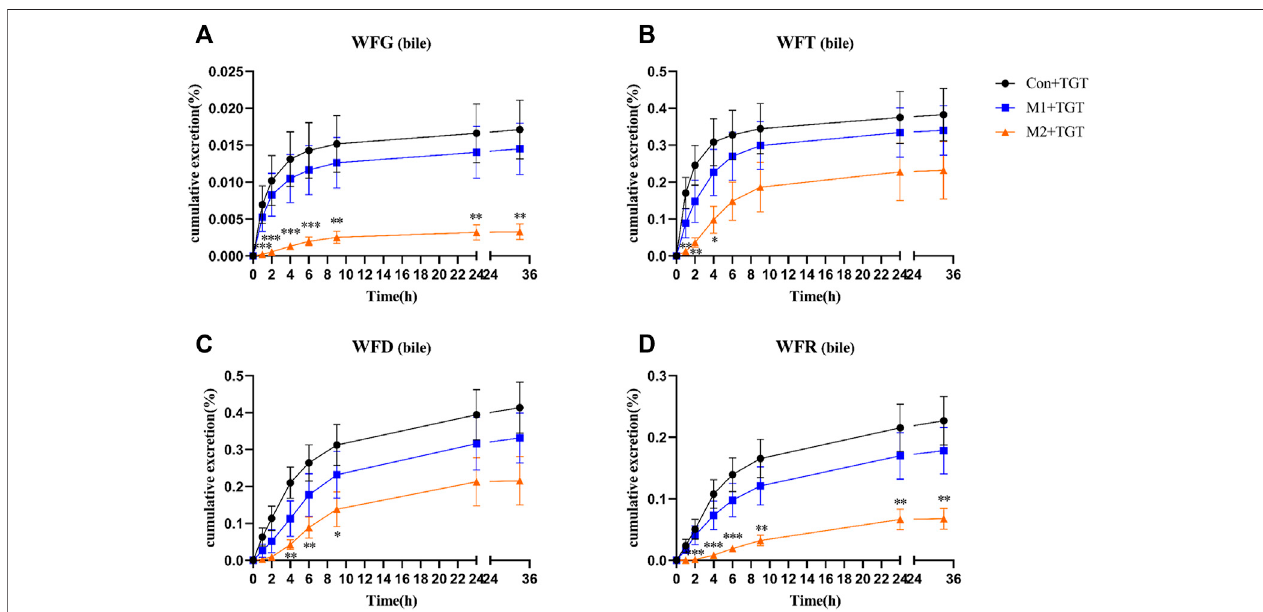
FIGURE10| ThecumulativebileexcretionratiosofthefourkeyTGTcomponentsinthenormalandtwotypesofadriamycin-induced-NSratsafterasingleTGToral gavagedoseof10 mg/kg(mean±SD, n =7).Thenormalrats,Con+TGT,blackcircle C ;theearly-stageNSrats,M1+TGT,bluesquare ;theadvanced-stageNSrats,